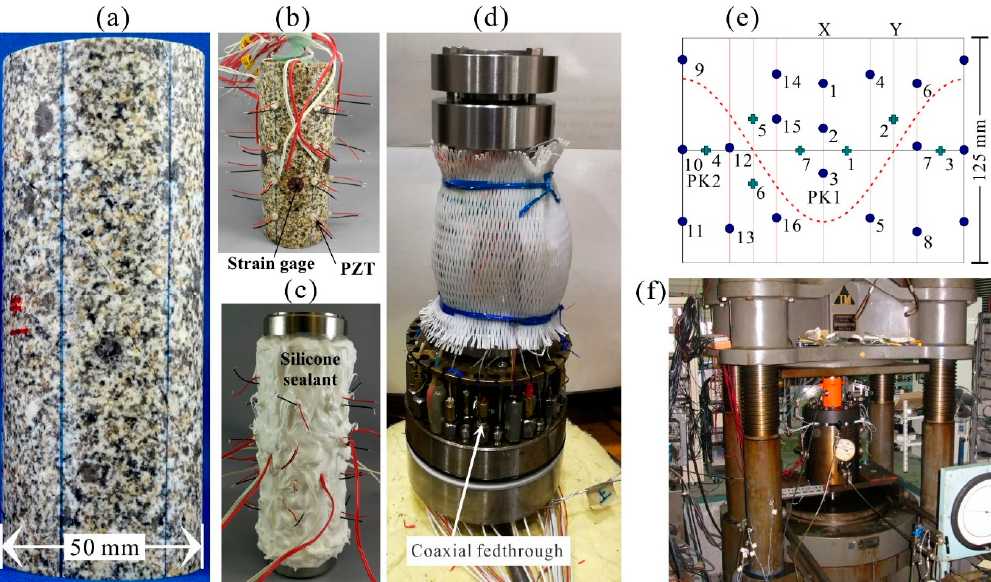
Figure 1. ( a ) Photograph of the test specimen. ( b ) Specimen with piezoelectric transducers (PZT) and cross-type strain gauges mounted. ( c ) Specimen and endpieces covered with silicone sealant. ( d ) Specimen-cover assembly. ( e ) Plot showing the distributions of PZTs (solid circles) and cross-type strain gauges (crosses). ( f ) Photograph of the load frame used in the test. The maximum amplitudes of AE signals from PK1 and PK2 were recorded by two peak detectors and were used for the calculation of seismic b -value.